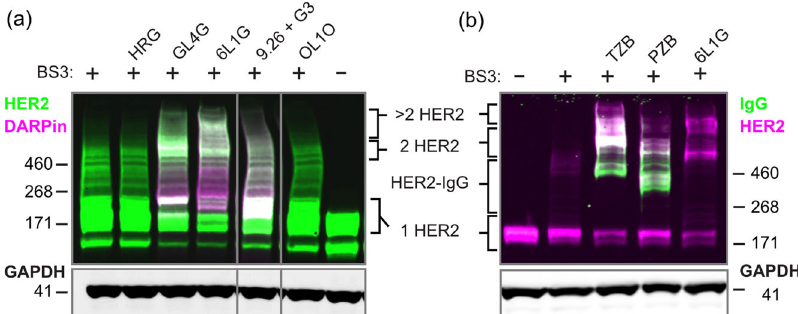
Fig. 2 Oligomerization of HER2 (~180 kDa) by bipDARPins and antibodies on BT474 cells analyzed by chemical crosslinking and two-color western blot. a Comparison of the size of HER2 complexes after treatment with the bipDARPin 6L1G (32 kDa) with those obtained with growth factor heregulin (HRG, 27 kDa), monovalent DARPins (9.26 and G3, ~12 kDa each) or a bivalent, monoparatopic DARPin (GL4G, ~30 kDa). Primary antibodies against HER2 and DARPins were used. b Crosslinked HER2 complexes upon treatment with antibodies trastuzumab (TZB, ~145 kDa) and pertuzumab (PZB, ~145 kDa), detected by primary antibodies against HER2 and human